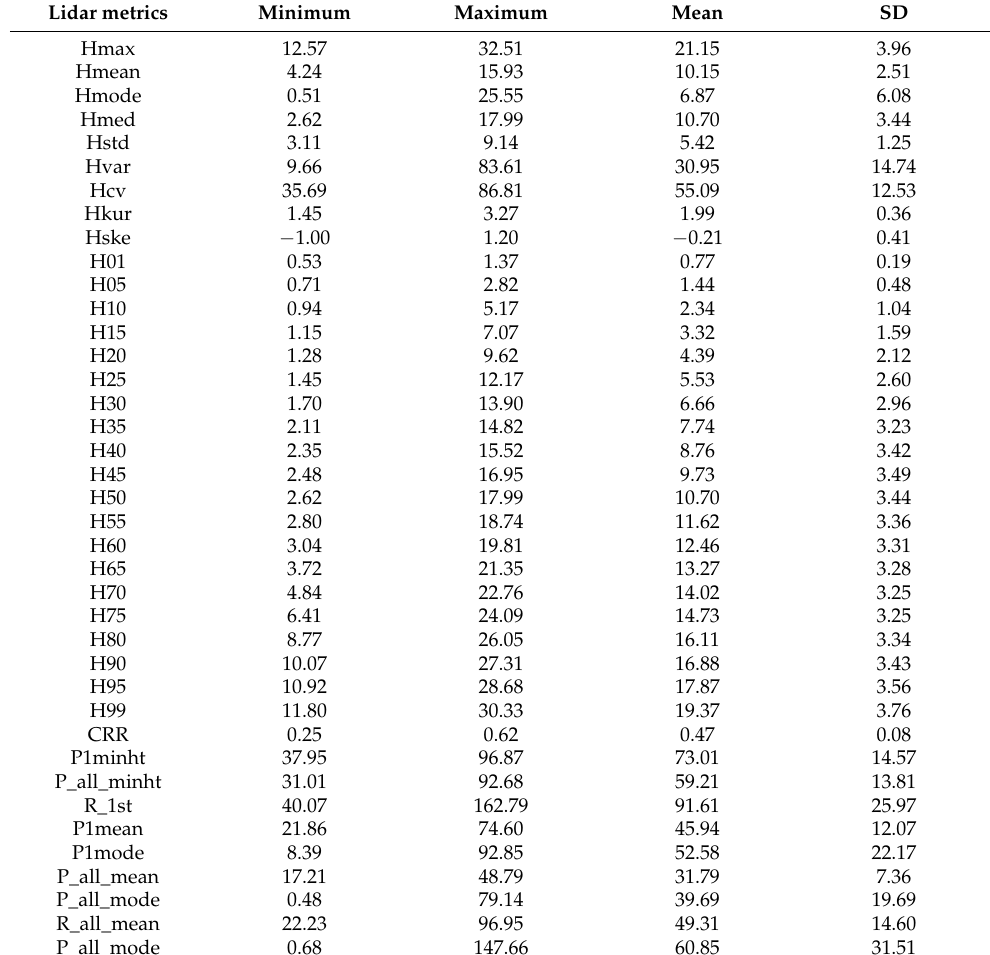
Table 3. Summary statistics of thirty-nine lidar